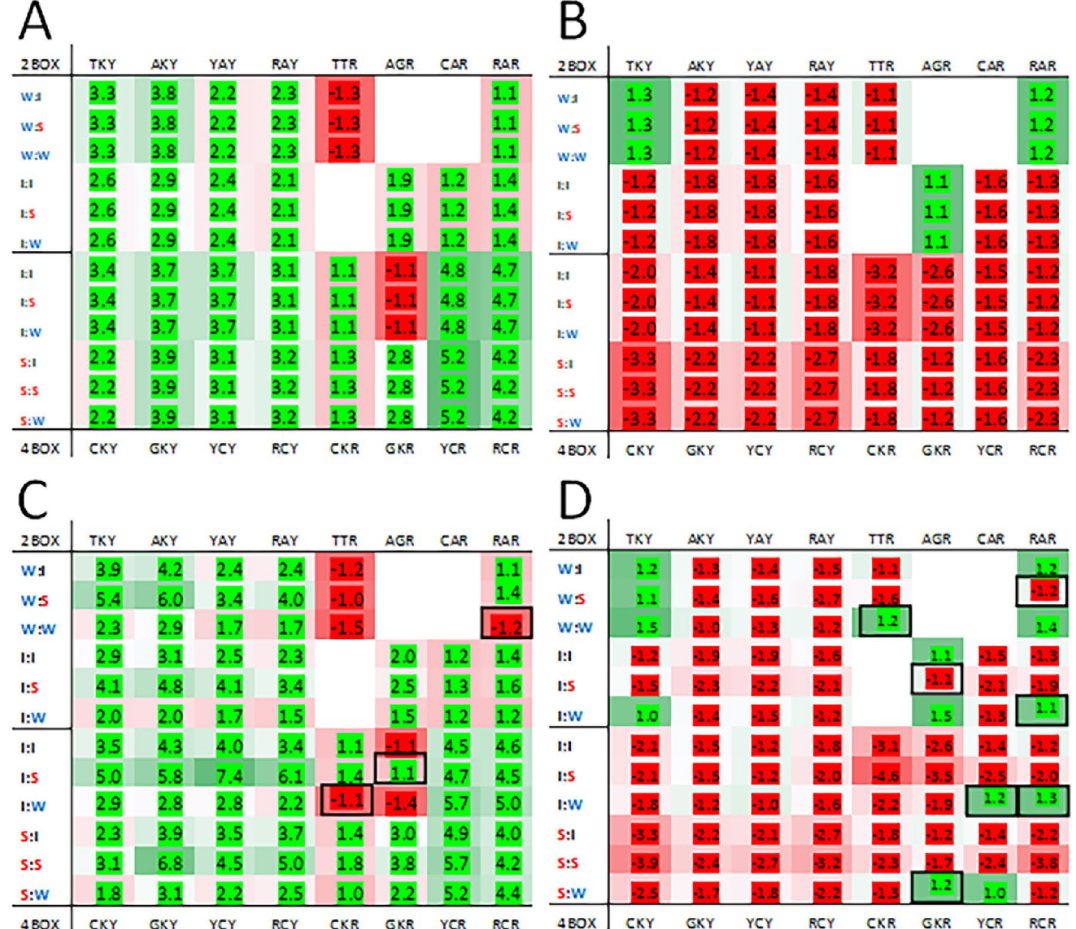
Figure 3. Heatmaps for Coronaviridae ( A and C ) and Herpesviridae ( B and D ). Heatmaps from the expected codon pairs are shown in the top panels ( A and B ) and heatmaps from the observed codon pairs in the lower panels ( C and D ). Features of the heatmaps are described in the “Methods” section. Black boxes indicate cells with biases opposite of the expected and with a frequency greater than 1.05 for either observed or expected